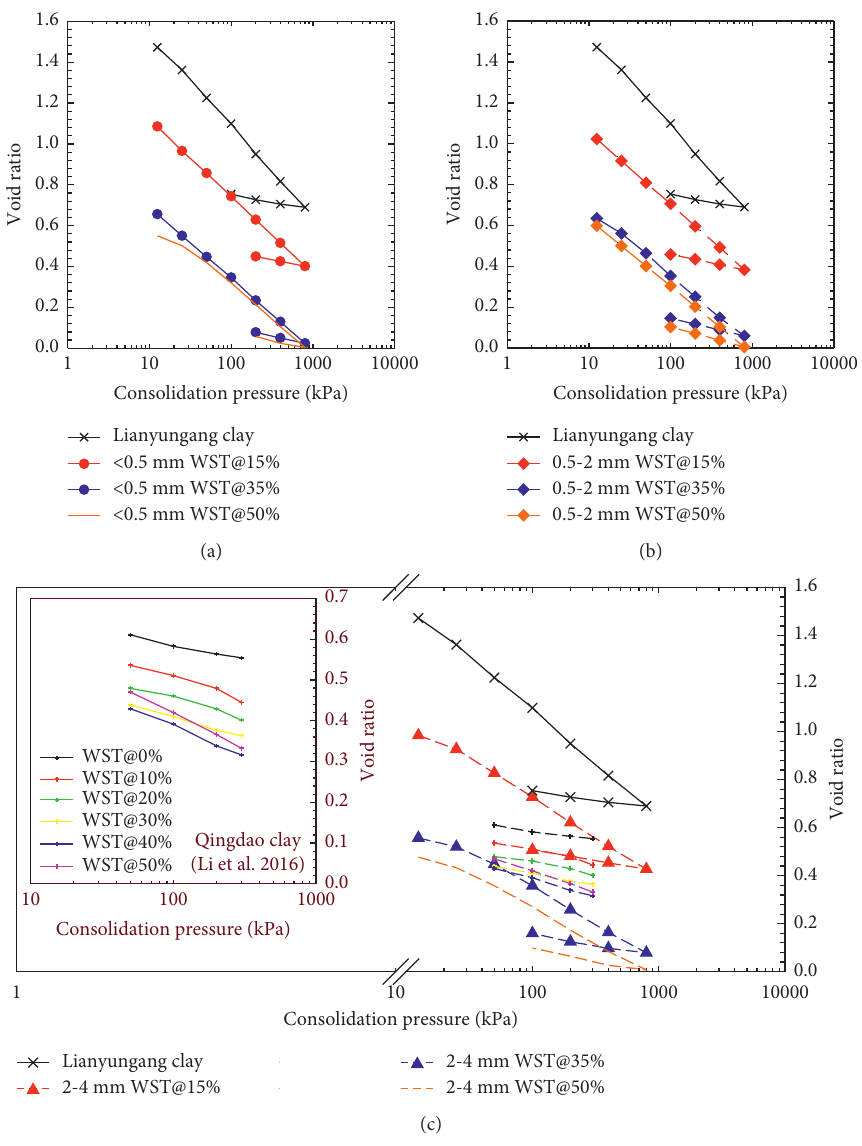
Figure 3: Compression curves of Lianyungang marine soil reinforced at different WST contents with shred sizes of (a) < 0.5mm, (b) 0.5–2.0 mm, and (c) 2.0–4.0mm and WST-clay composites from